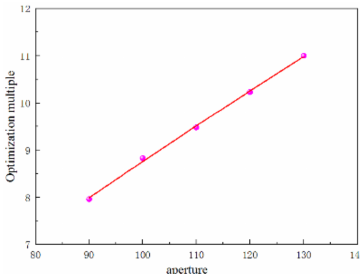
Figure 17. Optimization